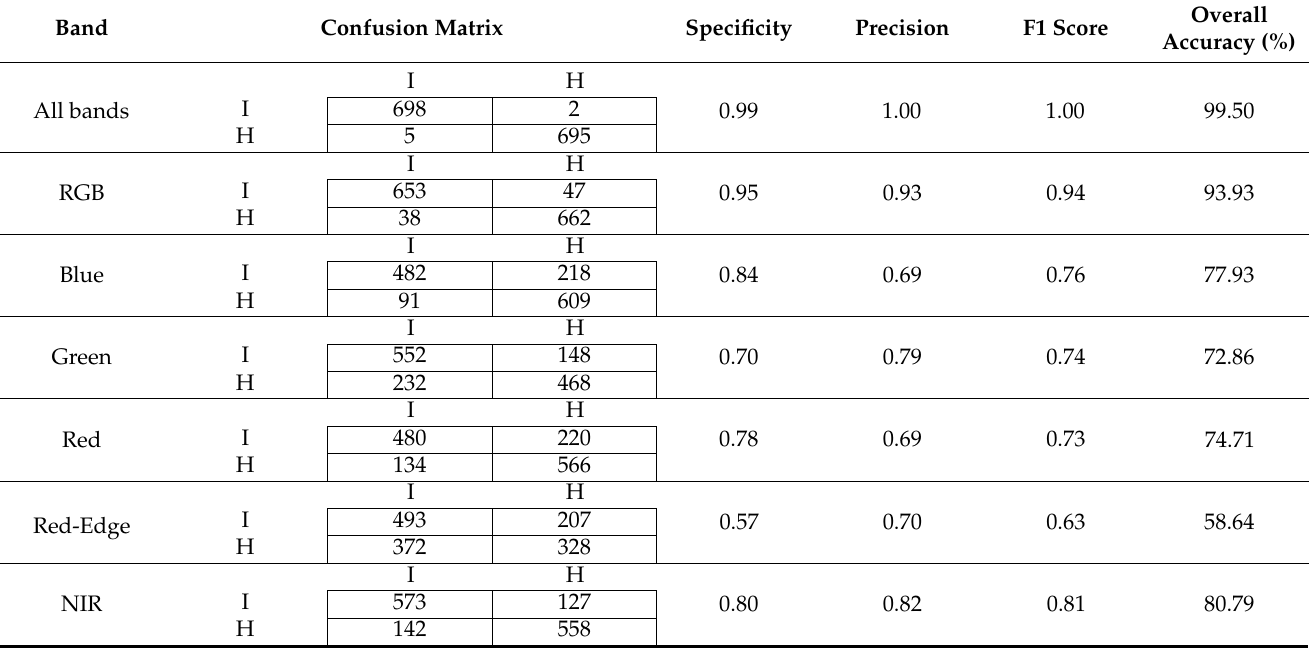
Table A1. Confusion matrix and related statistics when a fine Gaussian Support Vector Machine (SVM) classifier is trained with the blue, green, red, red-edge, NIR band images to classify 700 healthy (H) and 700 infected (I) pixels from cucumber images collected inside a greenhouse with a Micasense© Red Edge